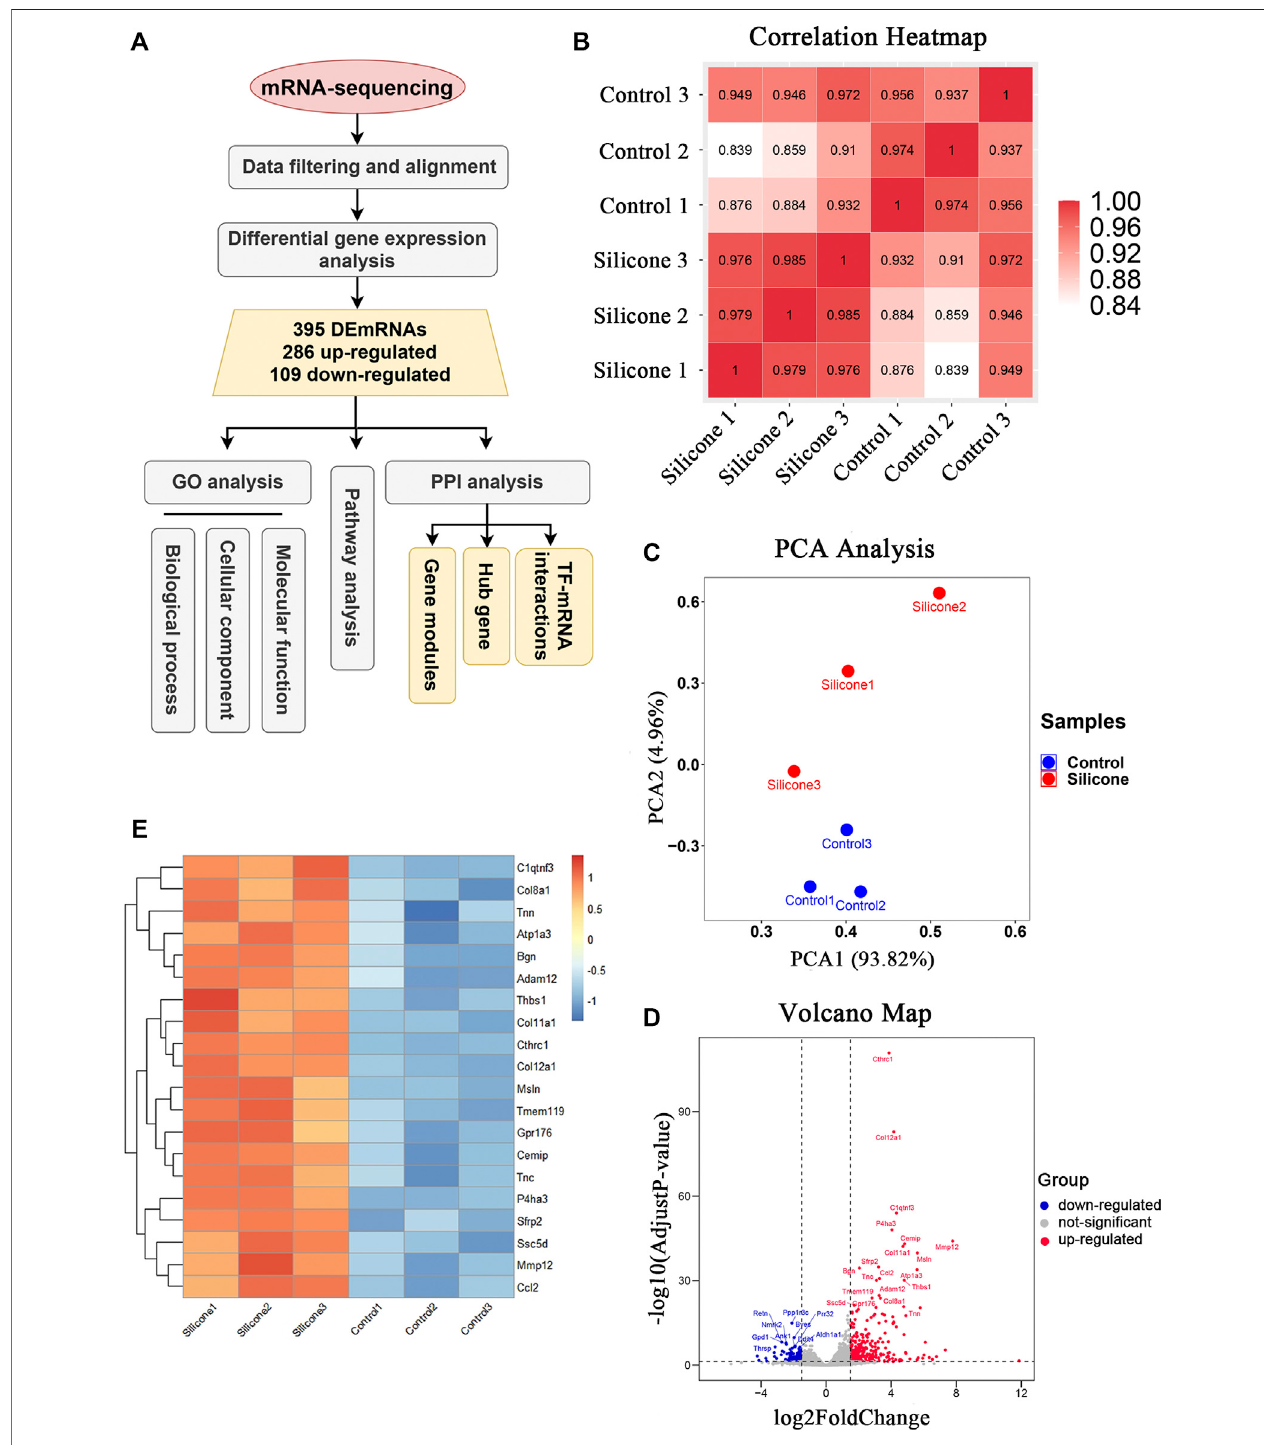
FIGURE 2 | The quality control of samples and the identi fi cation of DEmRNAs between silicone group and control group. (A) Flowchart of data acquirement, processing, analysis, and validation. GO, Gene Ontology; DEmRNAs, differentially expressed mRNAs; PPI, protein-protein interaction; TF, transcription factors. (B) HeatMap of correlation analysis with unsupervised hierarchical clustering between silicone and control group. (C) Scatter plot of PCA analysis between silicone and control group. PCA, principal component analysis. (D) Volcano map of differentially expressed genes between silicone and control group. (E) HeatMap of top 20